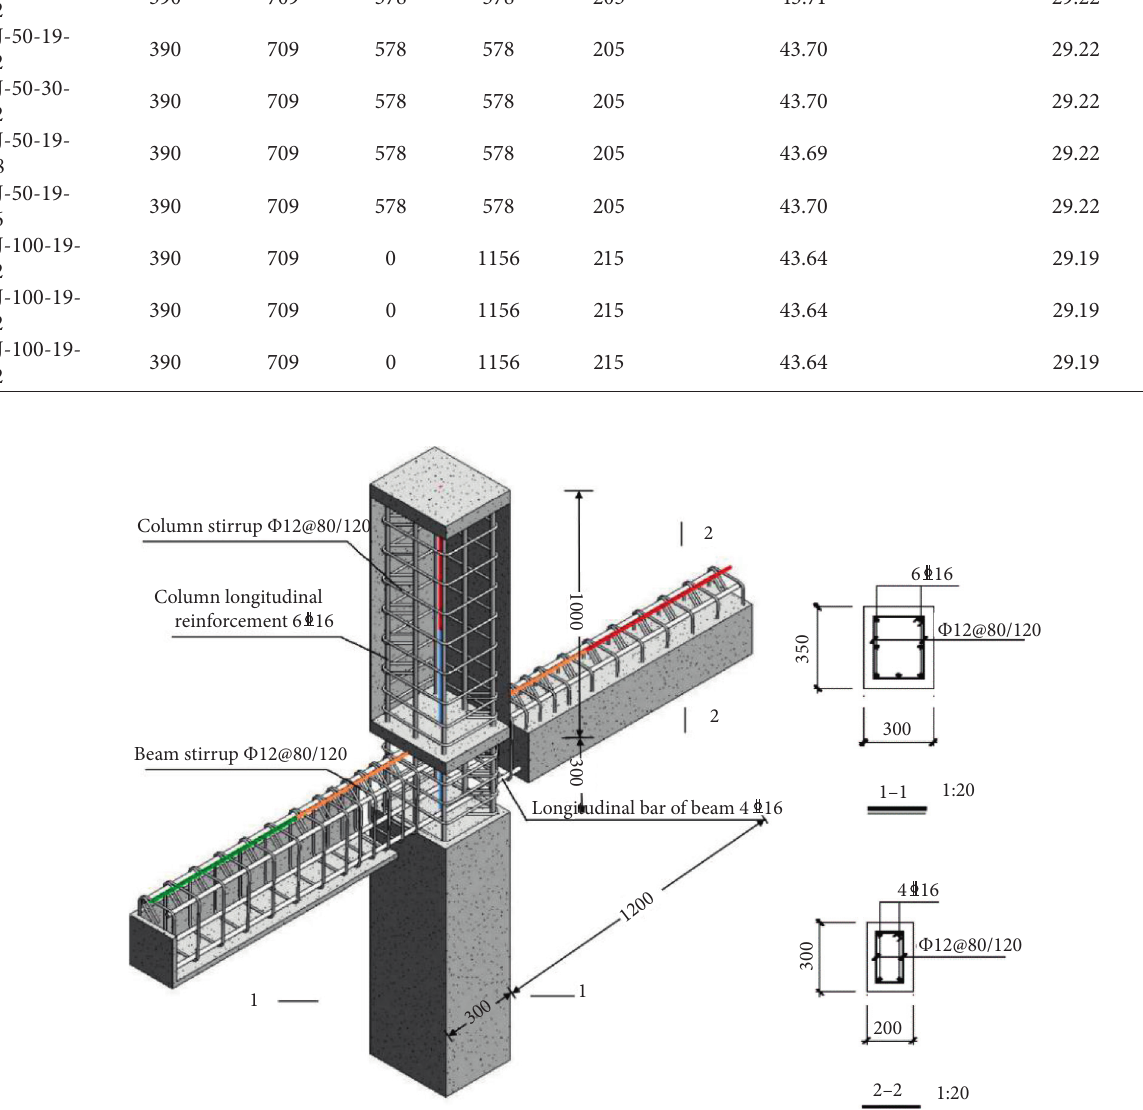
Figure 3: Dimensions and reinforcement details of specimens. Table 4: Mechanical properties of steel